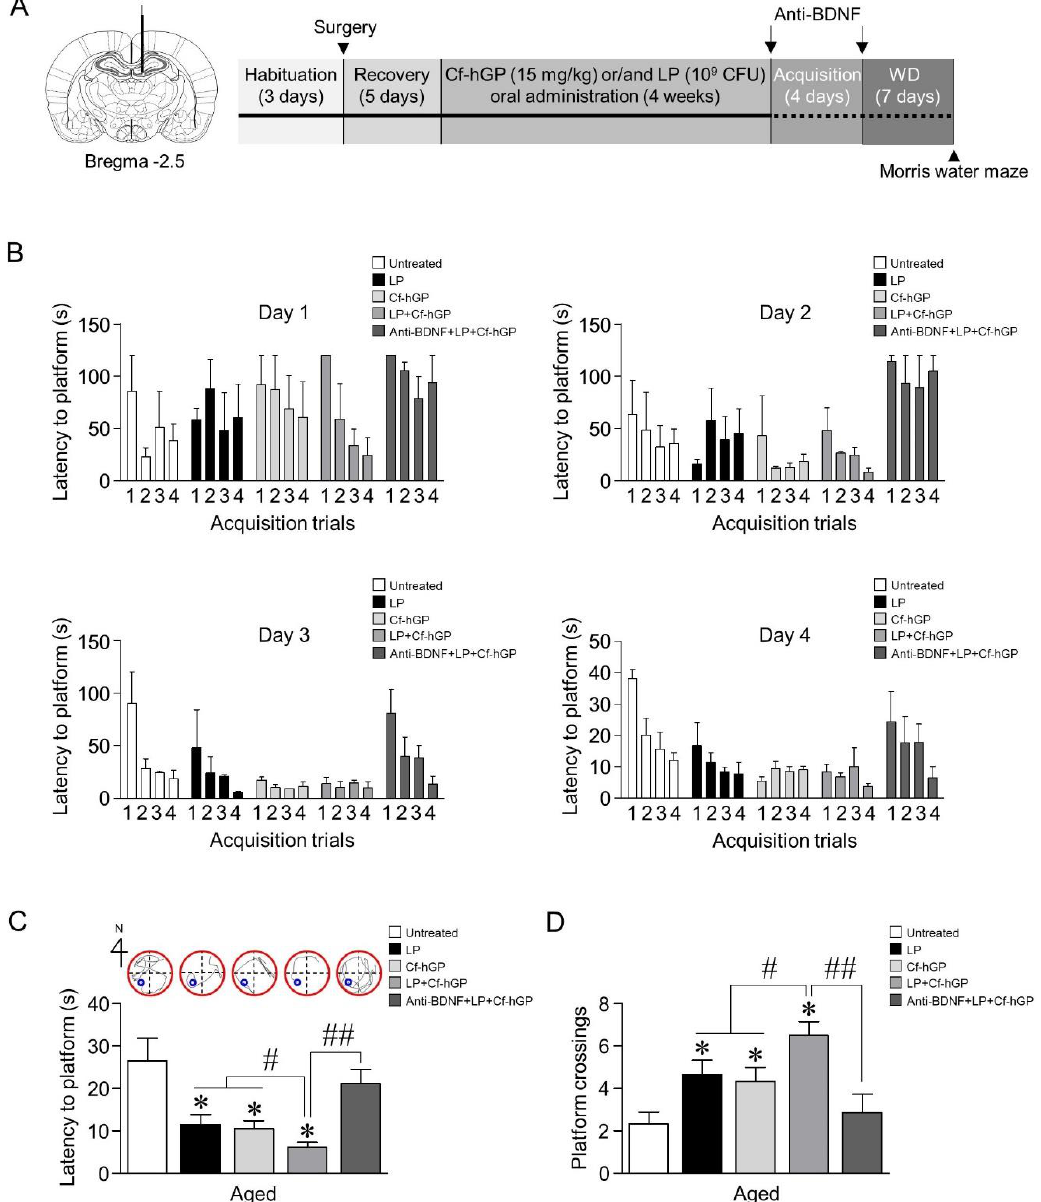
Figure 1. E ff ects of Cf-hGP on L. plantarum -induced cognitive improvement in aged rats. Cf-hGP (15 mg / kg) or L. plantarum (10 9 colony-forming units (CFU) / rat / day) was orally administered once a day for 4 weeks ( A ). After four weeks, acquisition training was performed ( B ). The co-treatment with Cf-hGP and L. plantarum synergistically downregulated the latency and upregulated the frequency of platform crossings compared to mono-treatment ( C , D ). * p < 0.05 versus untreated rats; # p < 0.05 versus the rats treated with only Cf-hGP or LP; ## p < 0.05 versus the rats co-treated with Cf-hGP and LP. Cf-hGP, Capsosiphon fulvescens glycoprotein; LP, Lactobacillus plantarum ; BDNF, brain-derived neurotrophic factor; WD, withdrawal period.